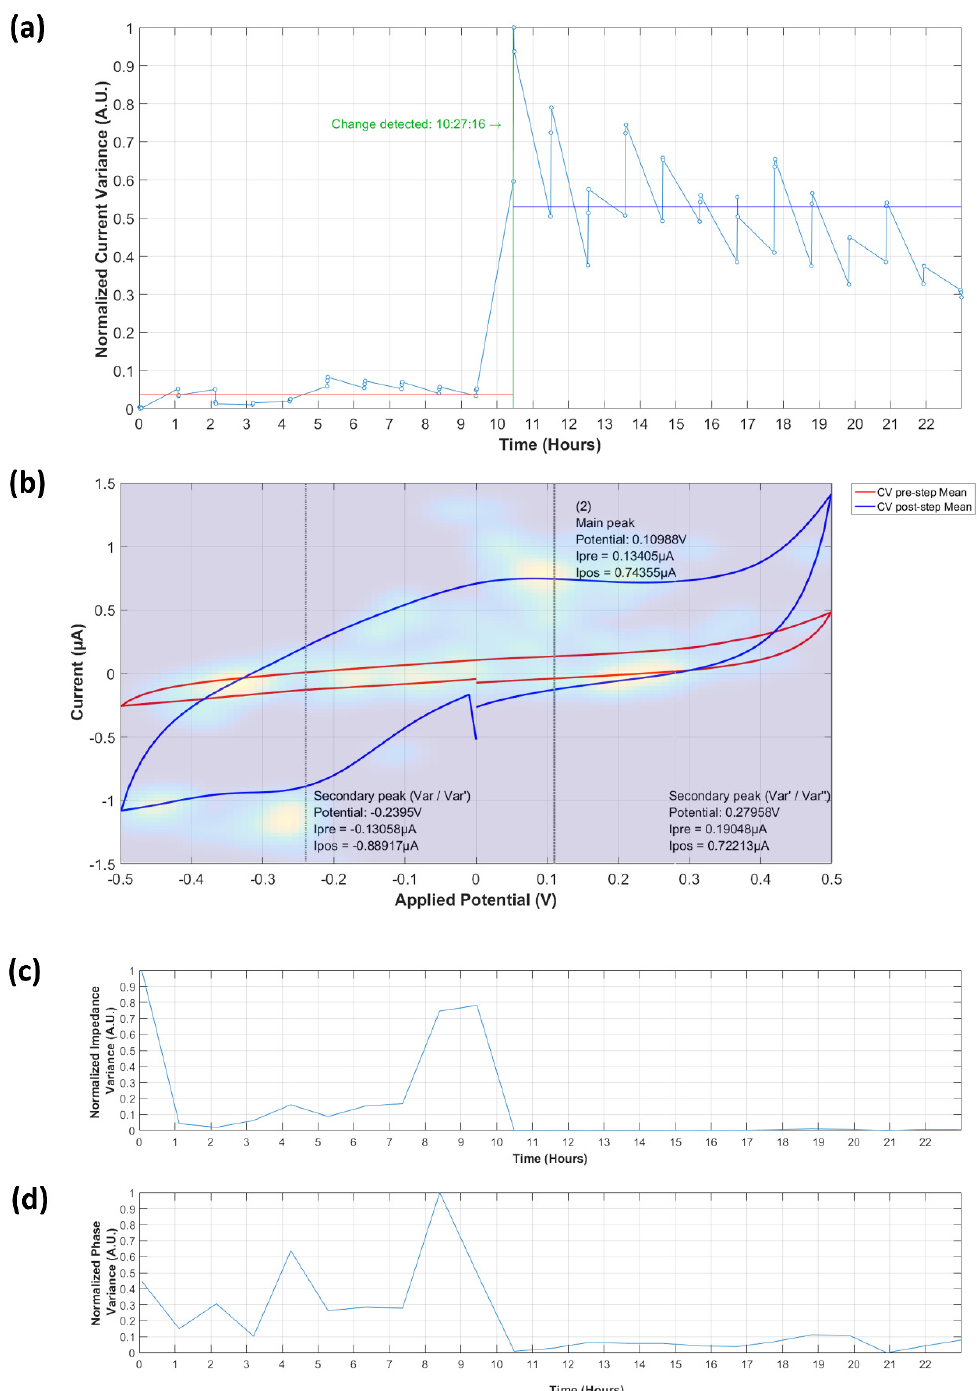
Figure A5. Recorded electrochemical response of a colonized microsystem for a ~24 h experiment. ( a ) Normalized current variance vs. time. Detected current peaks are indicated (peaks from variance to its first derivative ratio are indicated as Var/Var’, peaks from first derivative to second derivative ratio are indicated as Var’/Var’’. The current values at each peak are indicated for the mean before colonization event as I pre and for the mean after colonization event as I pos ). Note the characteristical step shape. ( b ) Recorded CV with calculated peaks and heatmap of detected peaks, where yellow represents a high concentration, and dark blue no peak. ( c ) Normalized impedance variance vs. time. ( d ) Normalized phase variance vs. time.